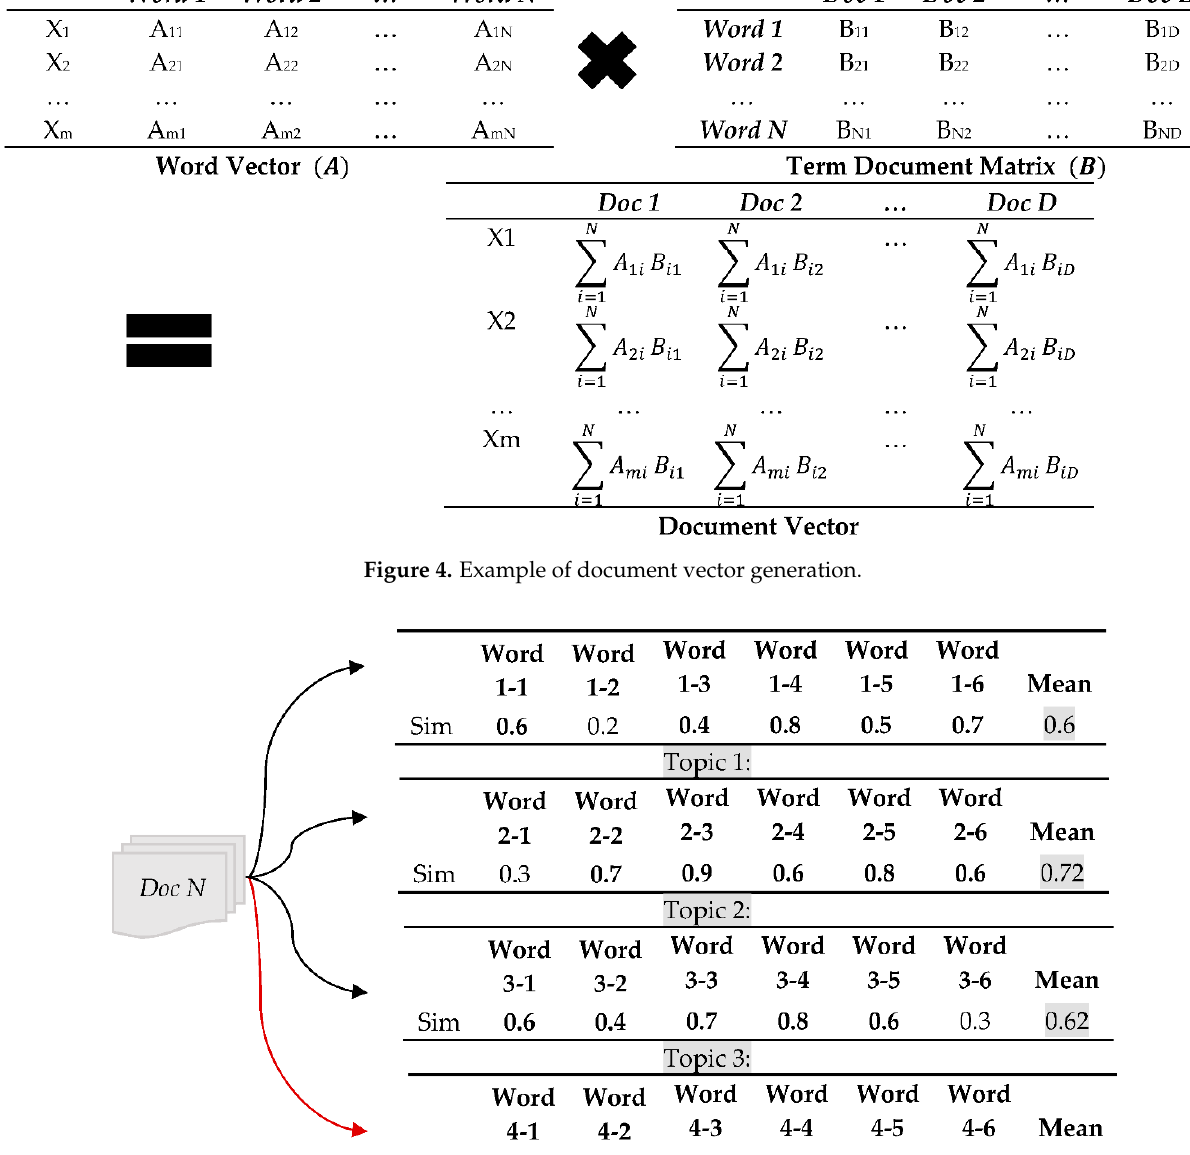
Figure 4. Example of document vector generation.